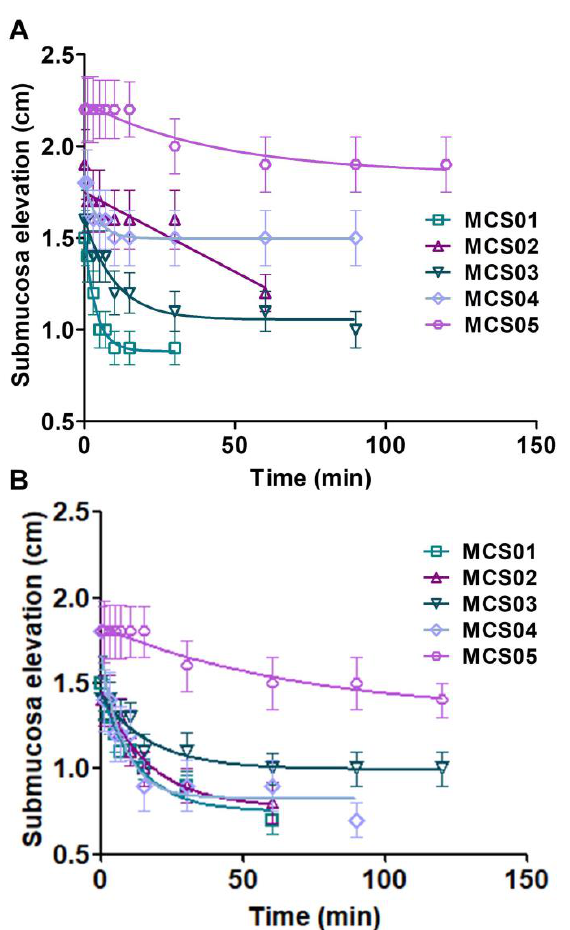
Figure 4. Submucosal elevation vs. time of polymeric solutions; ( A ) in stomach tissue; ( B ) in colon tissue. Data are expressed as mean ± SD of at least three independent experiments.